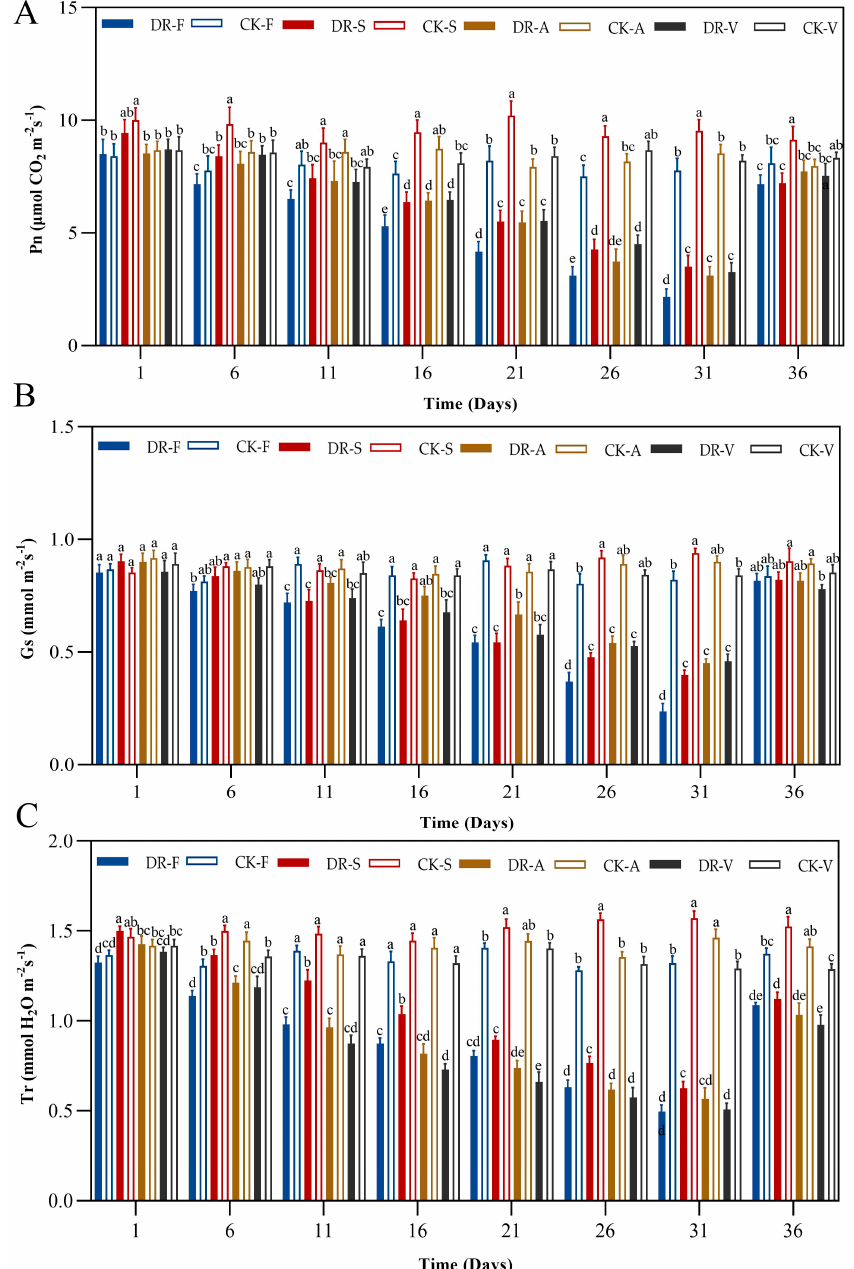
Figure 5. Effects of drought stress and rewatering on photosynthetic parameters of four oak species ( A ), net photosynthetic rate ( B ), transpiration rate ( C ), stomatal conductance. DR-F: drought-rewatering sample of Q. fabri ; CK-F: well watered sample of Q. fabri ; DR-S: drought-rewatering sample of Q. serrata ; CK-S: well watered sample of Q. serrata ; DR-A: drought-rewatering sample of Q. acutissima ; CK-A: well watered sample of Q. acutissima ; DR-V: drought-rewatering sample of Q. variabilis ; CK-V: well watered sample of Q. variabilis . Different lowercase letters indicate significant ( p < 0.05) differences among the four oak species subjected to the same treatment time.